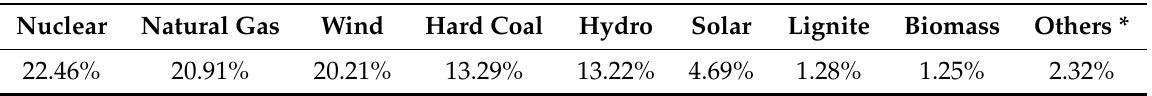
Table 8. Percentage of resources used during peak and off-peak hours in Spain [51].